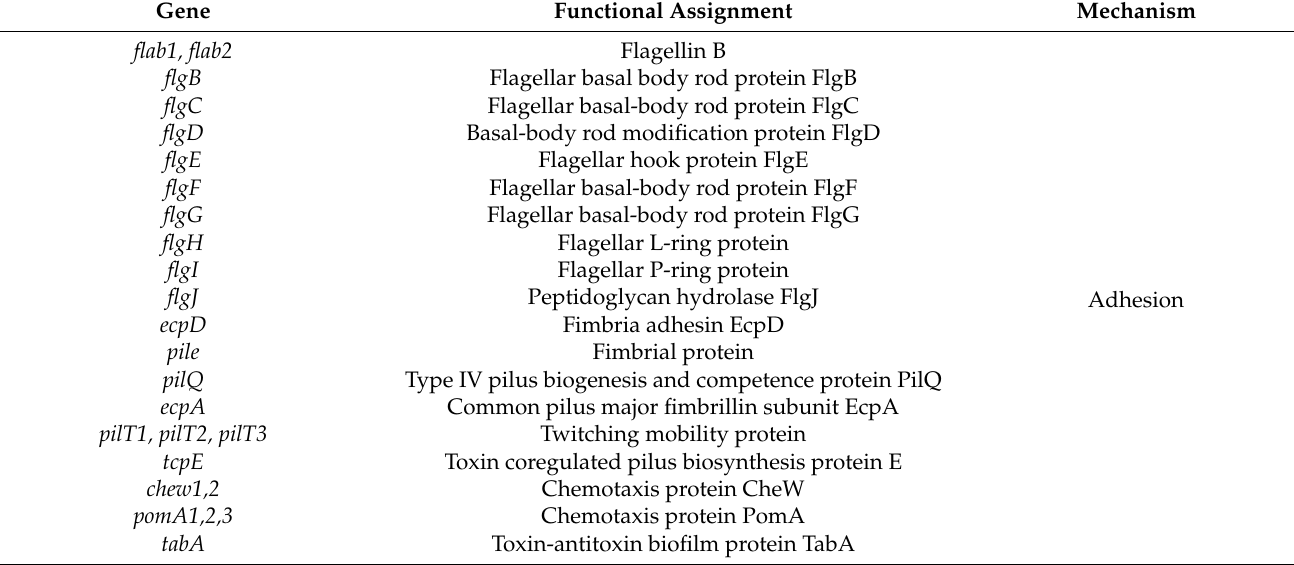
Table 3. Virulence genes detected in A. hydrophila 34SFC-3 genome, their corresponding functional assignment, and major virulence mechanism